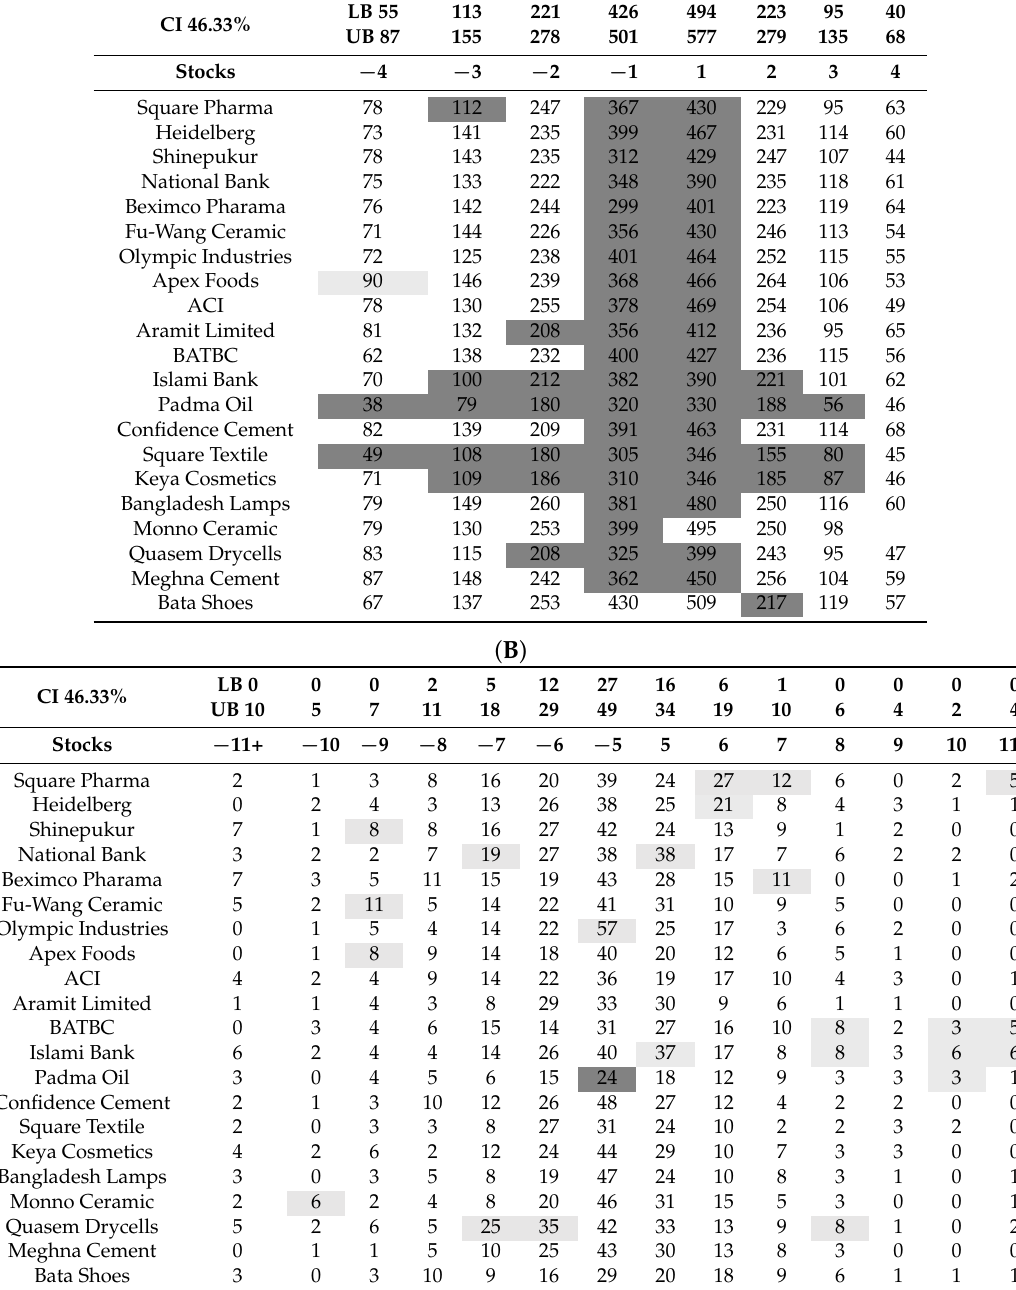
Table 4. ( A ) Number of Runs in the Middle of the Distribution (n between − 4 and +4) for DSE Stocks. ( B ) Number of Runs in the Tails of the Distribution (|n| equal to or greater than 5) for DSE